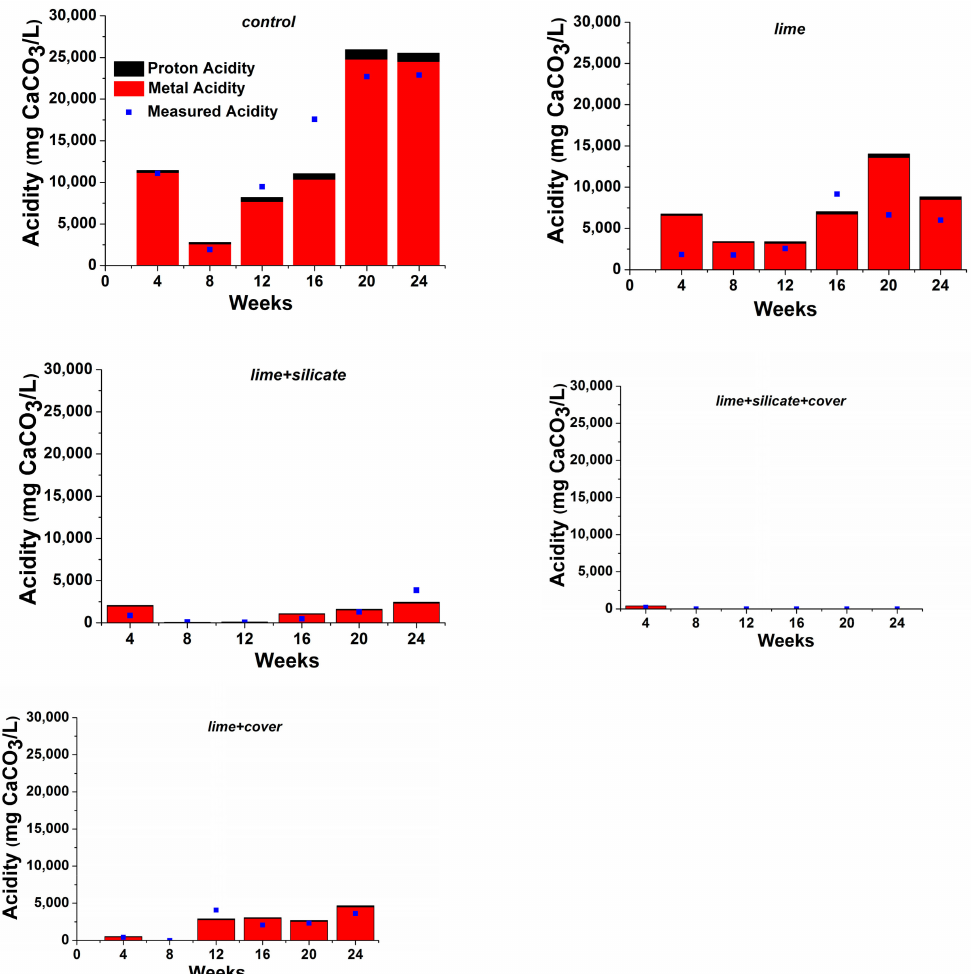
Figure 2. Measured acidity alongside calculated proton and metal acidities (mg CaCO 3 L − 1 ) for all KLCs.